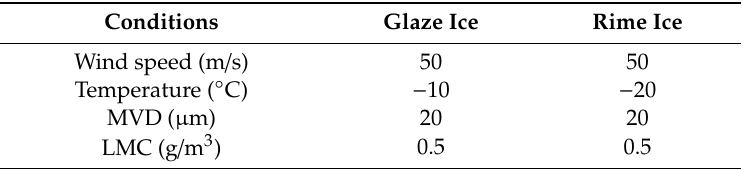
Table 4. Test conditions for glaze and rime